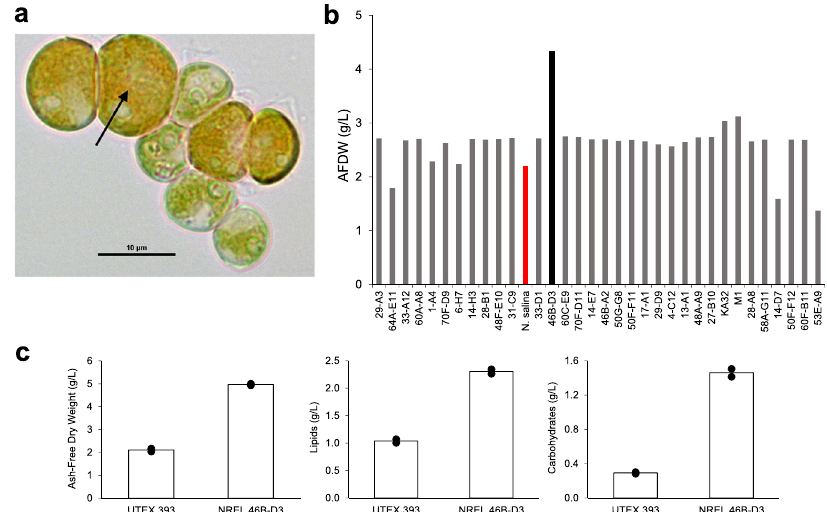
Fig. 1 Screening of Scenedesmus sp. NREL 46B-D3 and culture collection data. a Micrograph of alga Scenedesmus sp. NREL 46B-D3, black arrow indicates observed orange/red pigmentation throughout the cell. b Representative culture collection growth screening data. The high biomass accumulation capacity phenotype of Scenedesmus sp. NREL 46B-D3 following 6 days of growth is highlighted in black. Nannochloropsis salina CCMP 1776 is bolded in red for reference. c Endpoint growth comparison of UTEX 393 and NREL 46B-D3 following 9 days of growth-data presented is the average (bar) of two biological replicates